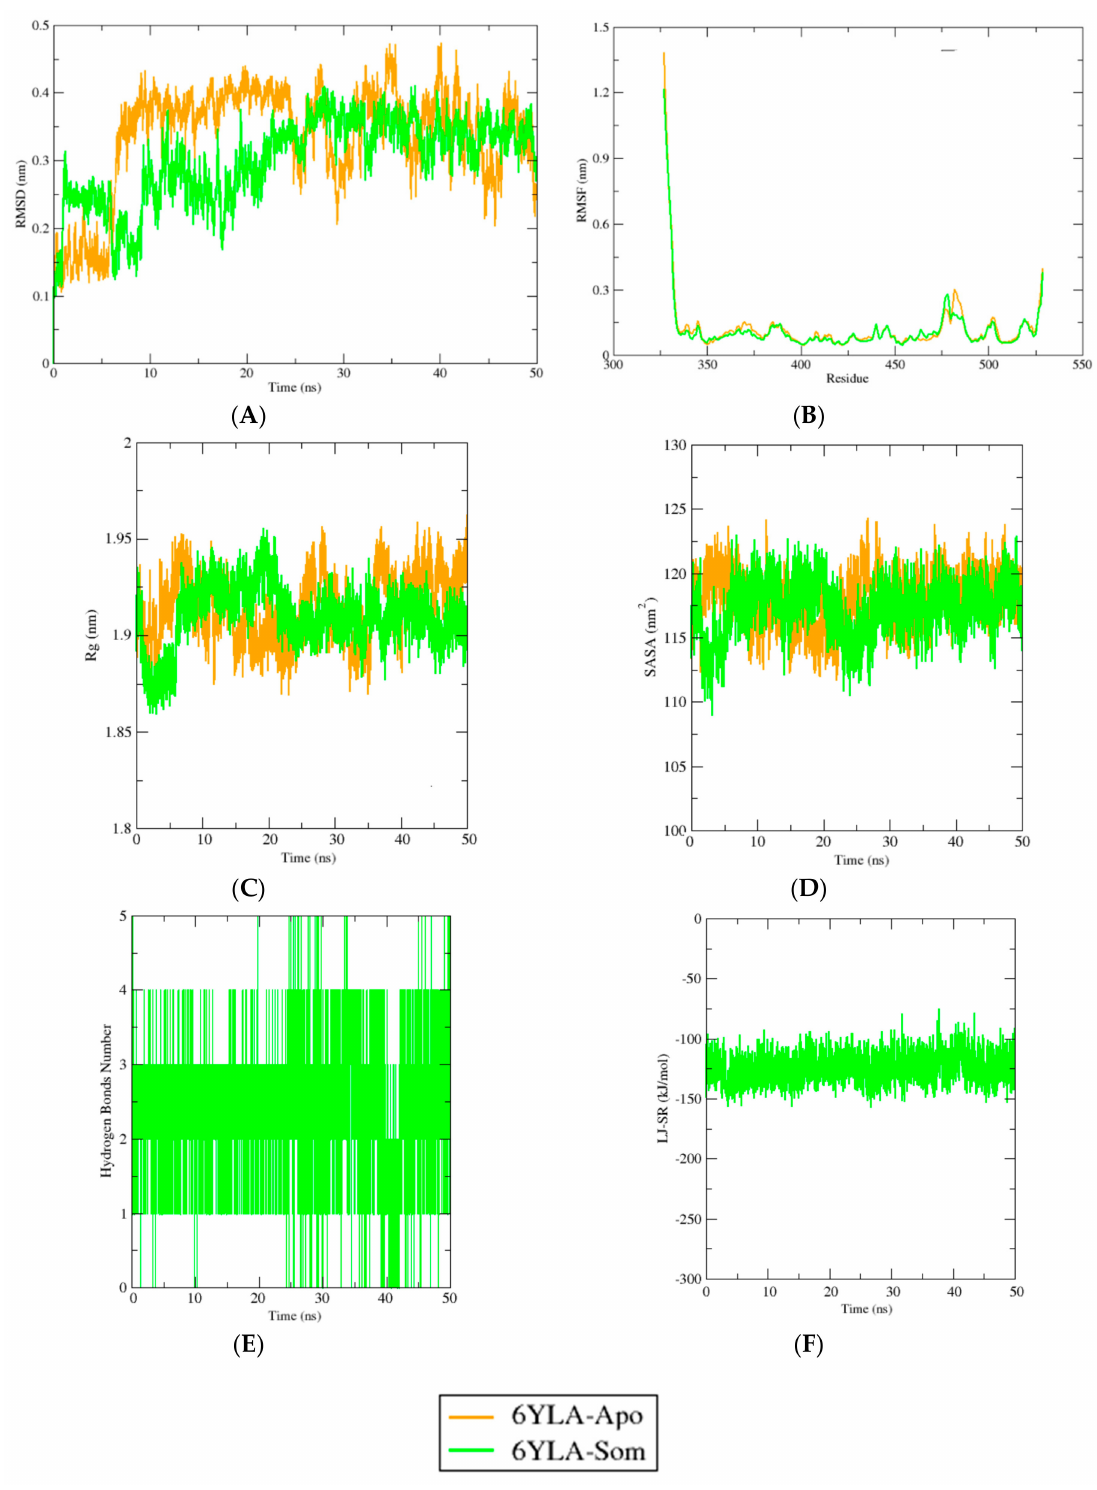
Figure 4. ( A ) RMSD, ( B ) RMSF, ( C ) Rg, ( D ) SASA, ( E ) intermolecular hydrogen bonds number, and ( F ) short-range Lennard- Jones protein-ligand interaction energy analysis of the apo form (6YLA-Apo), and somniferine (6YLA-Som) holo form of RBD of SARS-CoV-2 spike protein for 50